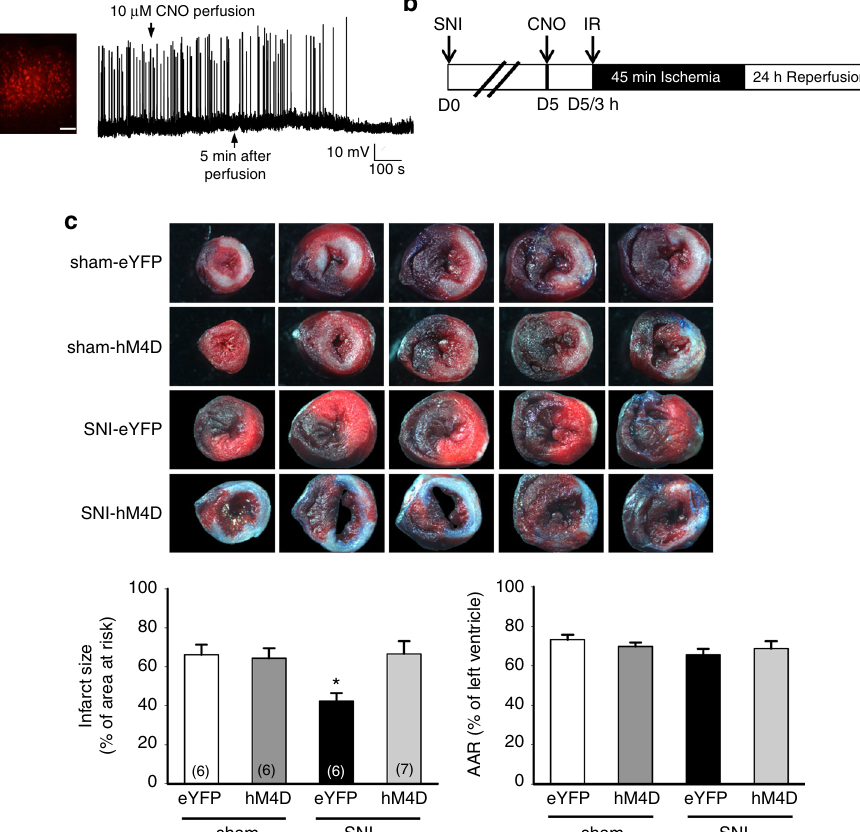
Fig. 7 Inhibition of PVA neuron with DREADD alleviates SNI-induced cardioprotection. a Immuno fl uorescent images of AAV-hM4D-mCherry ( red )- positive signals in PVA regions ( scale bar = 100 μ m). Evoked spontaneous action potentials recorded from hM4D-mCherry-positive PVA neurons with CNO bath perfusion. b Schematic of experimental design showing the timeline for SNI (D0), CNO IP injection (D5) and IR injury (3 h after CNO injection). c Representative images of TTC staining in heart cross-sections. Quanti fi cation results of infarct size and AAR in cardiac sections from eYFP and hM4D groups in sham and SNI animals. Activation of hM4D with CNO alleviates SNI-induced cardioprotection. * p < 0.05 vs. eYFP group. Error bars indicate SEM. Statistical signi fi cance was determined by one-way ANOVA ( c